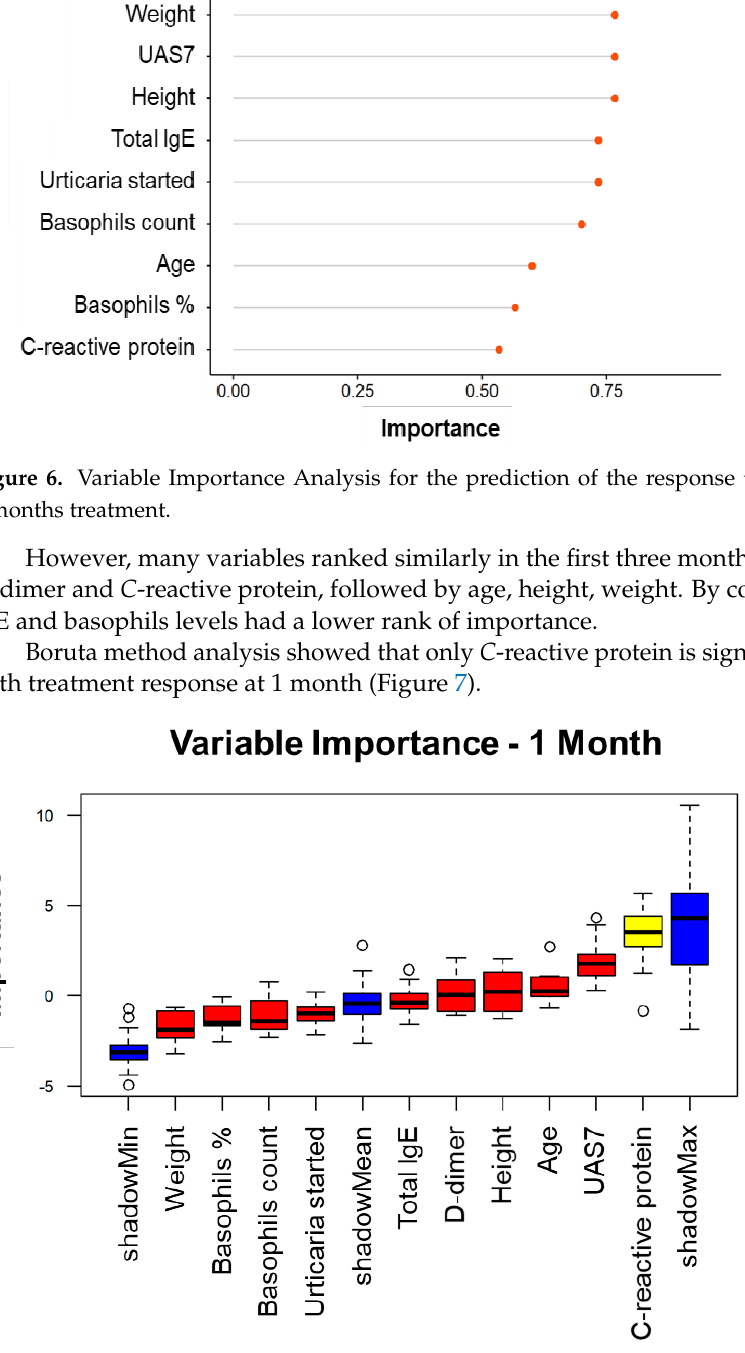
Figure 5. Variable Importance Analysis for the prediction of the response to omalizumab after 3 months treatment.